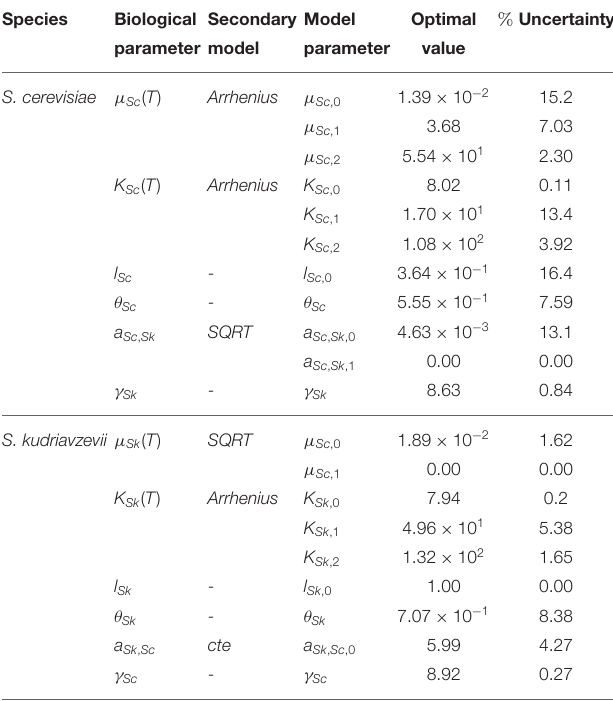
TABLE 1 | Best model parameter values and associated uncertainty. Species Biological Secondary Model Optimal % Uncertainty parameter model